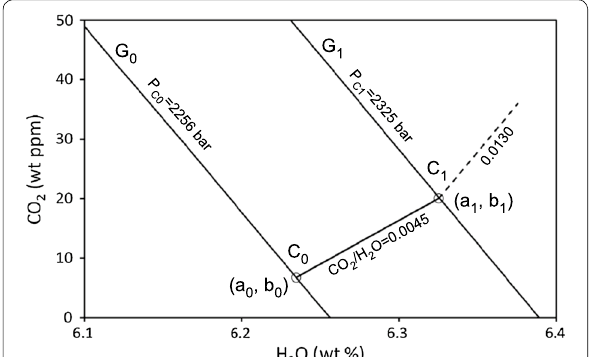
Fig. 11 H 2 O and CO 2 concentration dissolved in rhyolitic magma at 900 °C with isobaric vapor lines. G 0 and G 1 : isobaric lines at 2256 and 2325 bar,